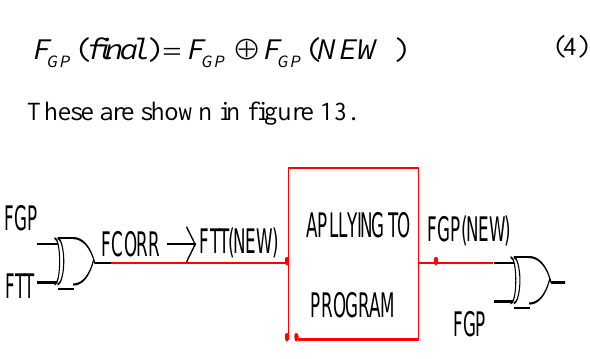
Figure 13. Block diagram for optimized